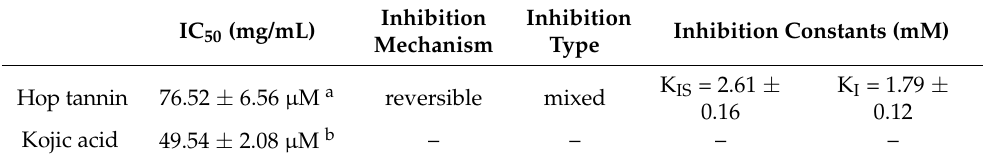
Table 1. Tyrosinase inhibition activity of the hop tannins 1 .